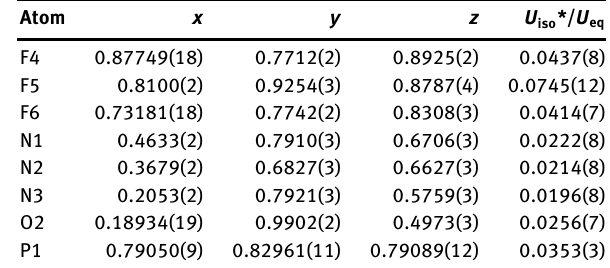
Table 2: Fractional atomic coordinates and isotropic or equivalent isotropic displacement parameters (Å 2